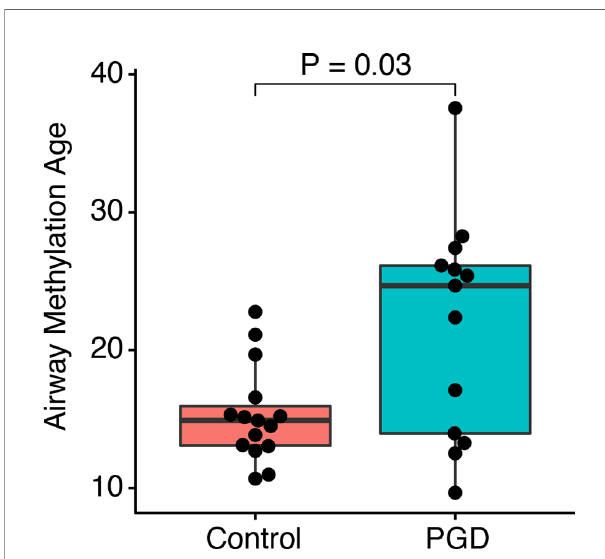
FIGURE 2 | PGD is associated with accelerated DNA methylation age. DNA methylation age for non-PGD and PGD subjects was compared in airway cell cultures taken 12 months after lung transplantation. Groups were compared by Mann-Whitney U test. By linear regression, airway methylation age was 6.5